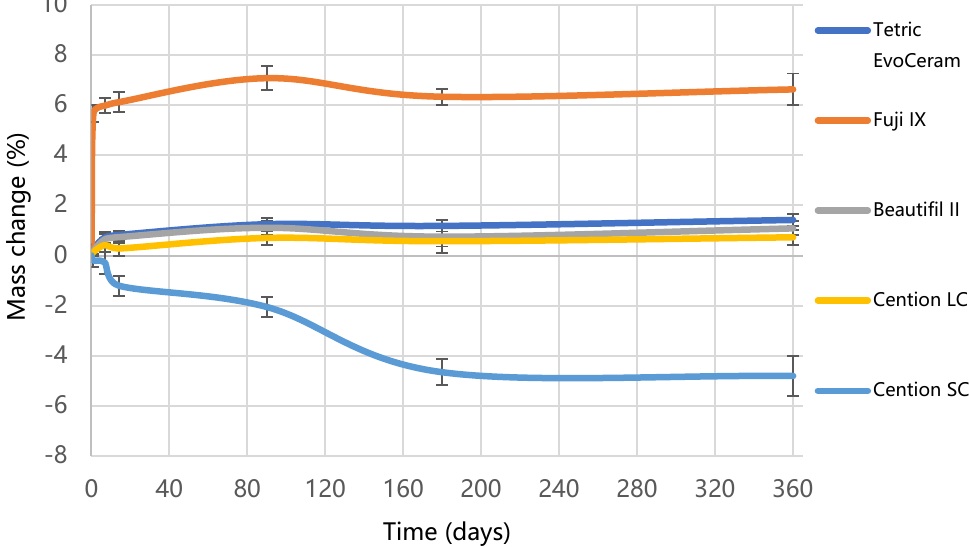
Figure 6. Mass change over one year of water immersion for tested materials. Error bars denote standard deviations.